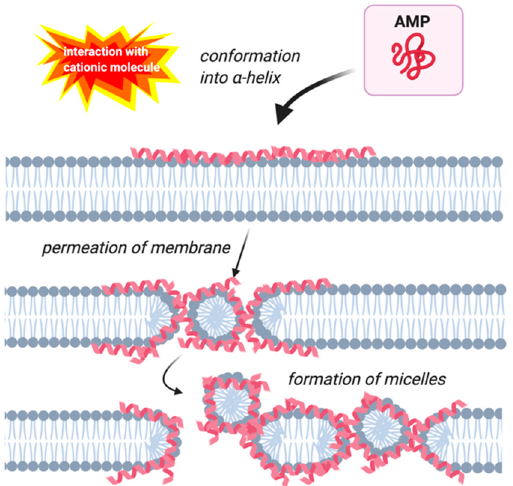
Figure 1. Membrane permeation by the carpet model. Antimicrobial peptides (AMPs) are indicated by pink helices. Image created with BioRender.com.